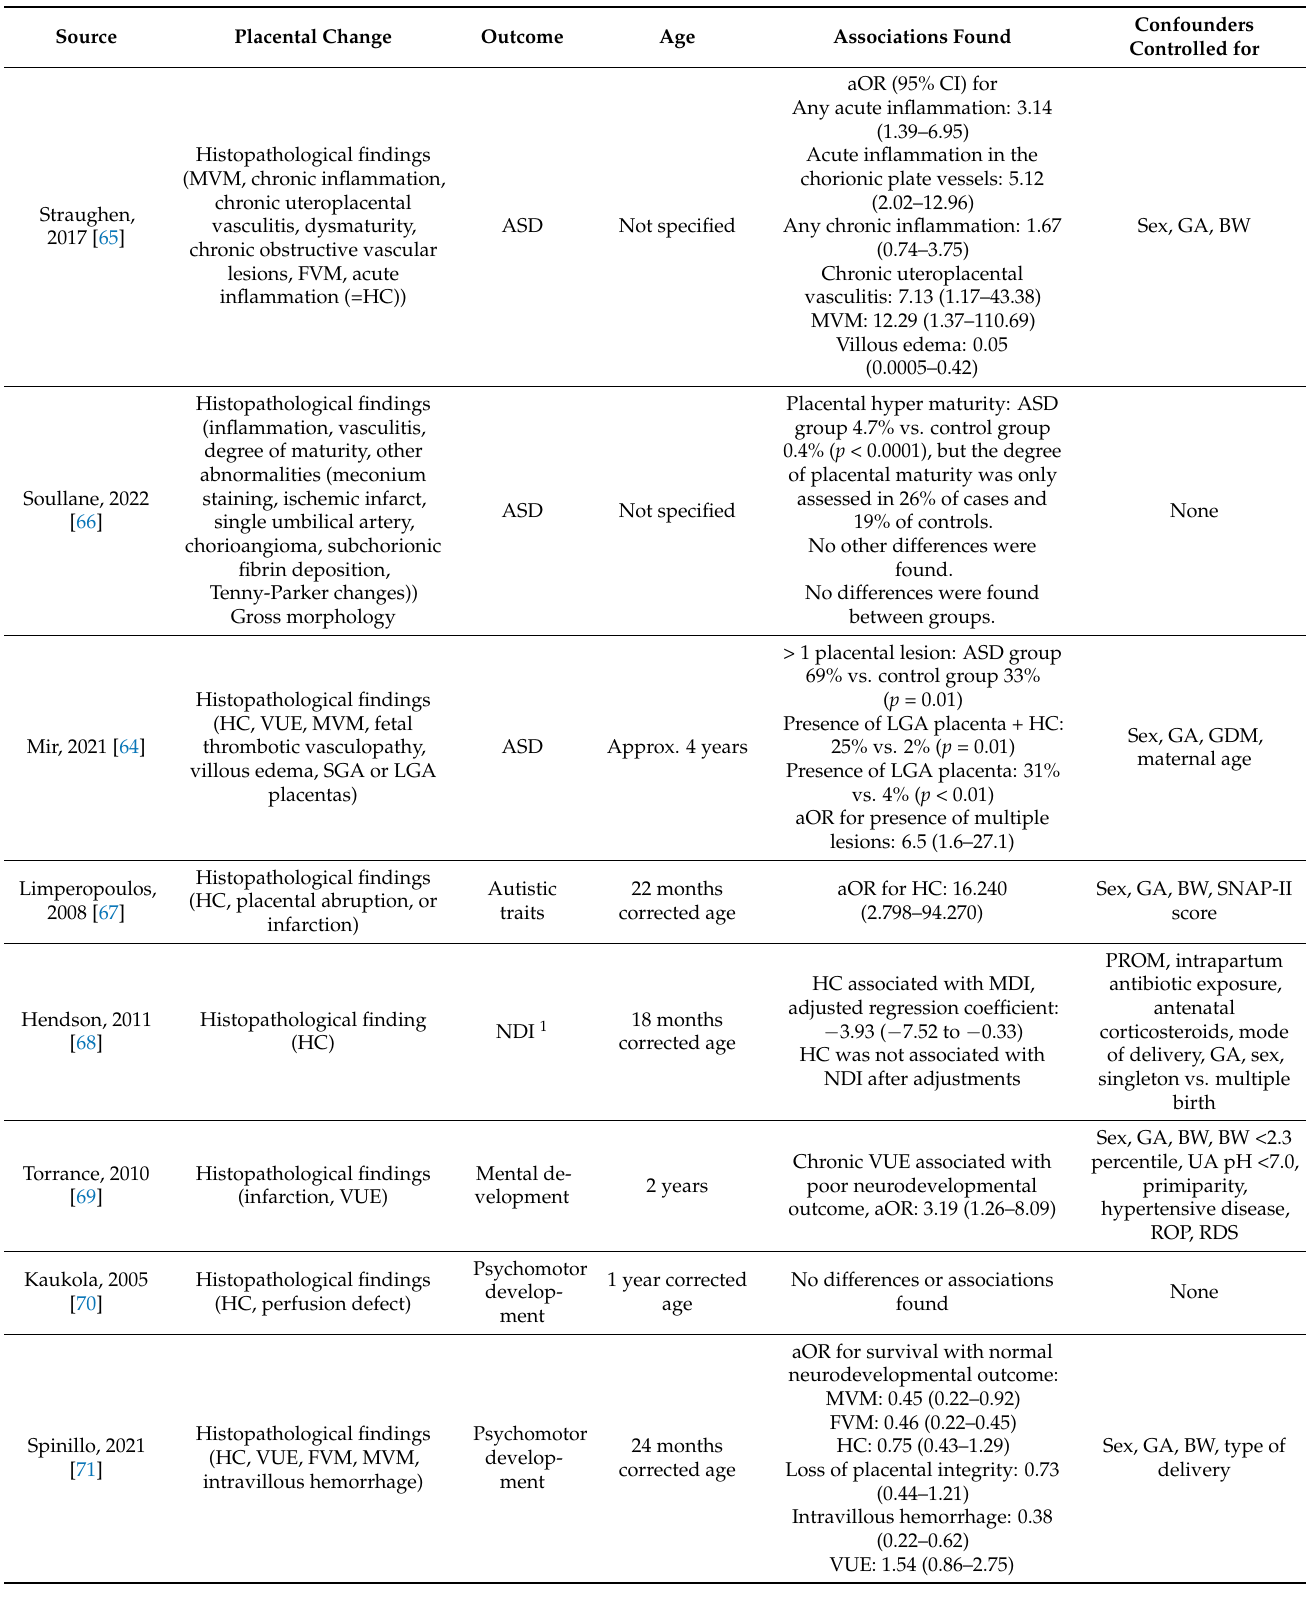
Table 3. Results from the included studies sorted by placental